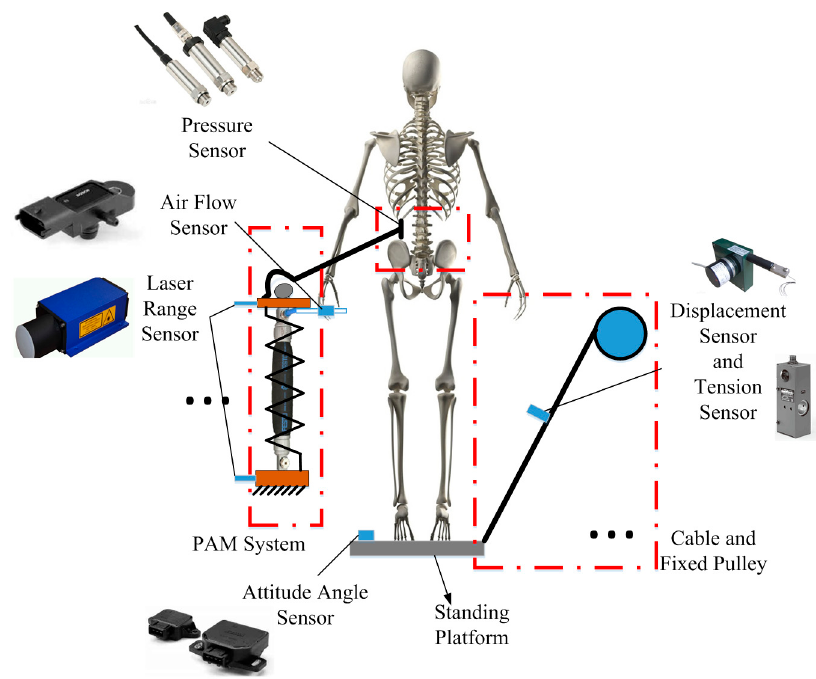
Figure 2. Assignment of the sensors.